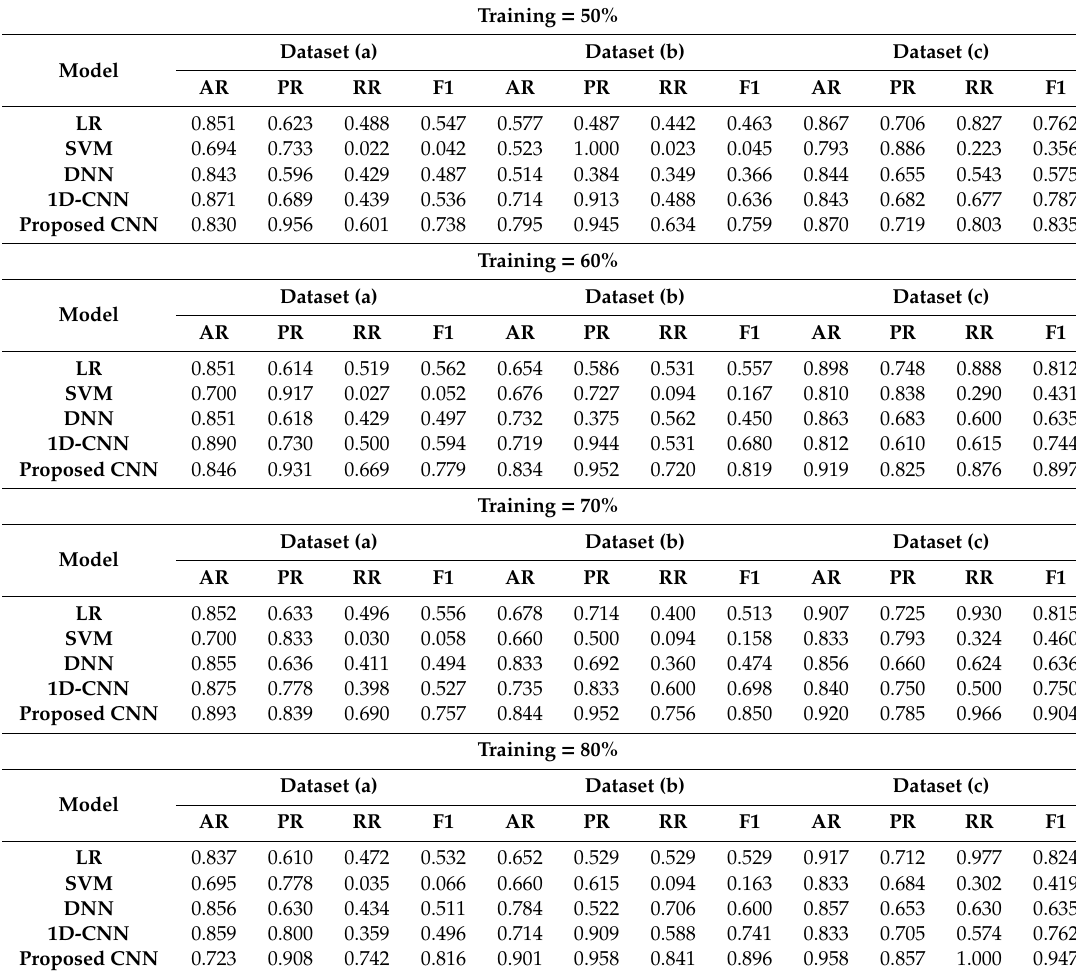
Table 4. Results on di ff erent datasets with di ff erent